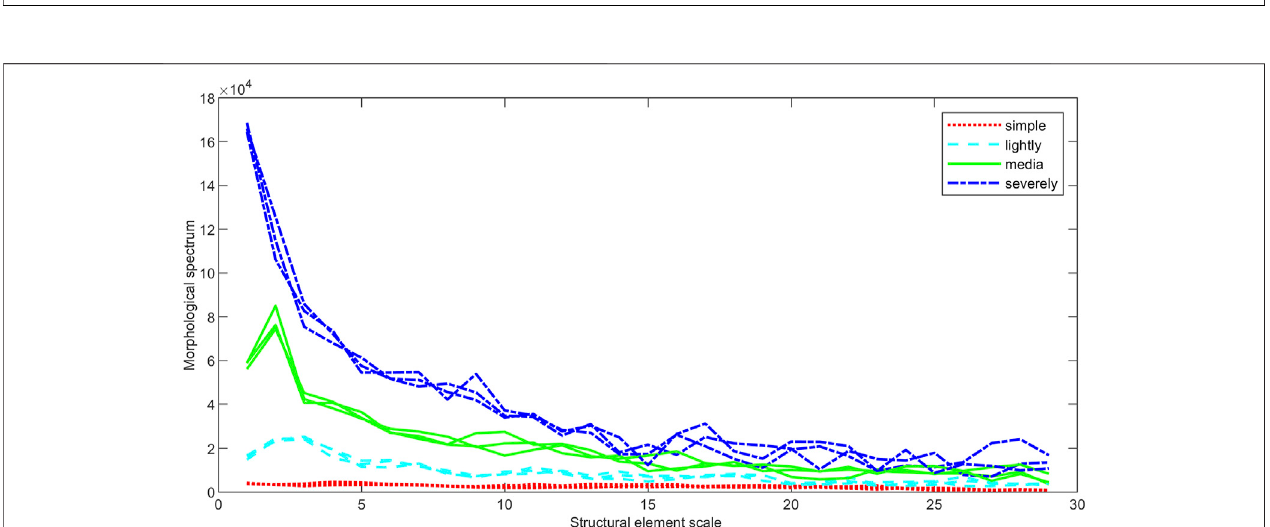
FIGURE 3 | MS analysis result of square SE.